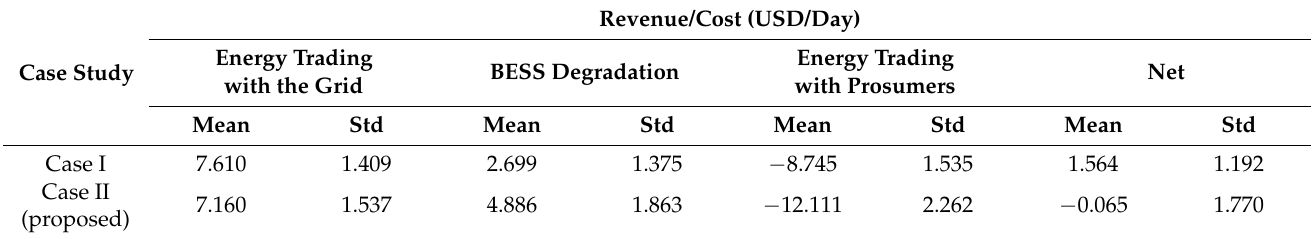
Table 5. The mean and standard deviation of each objective function of the aggregator.